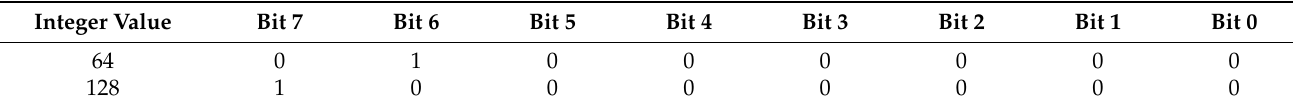
Table 2. Integer values selected from the F-mask, representing pixels without clouds, cloud shadows, water, and high aerosol level. The value 0 at the indicated bit means absence, while 1 indicates presence. Bit 7 and Bit 6 are the aerosol level (01 represents low level and 10 represents medium level); Bit 5 is water; Bit 4 is snow or ice; Bit 3 is cloud shadow; Bit 2 is adjacent to cloud shadow; Bit 1 is cloud; and Bit 0 is